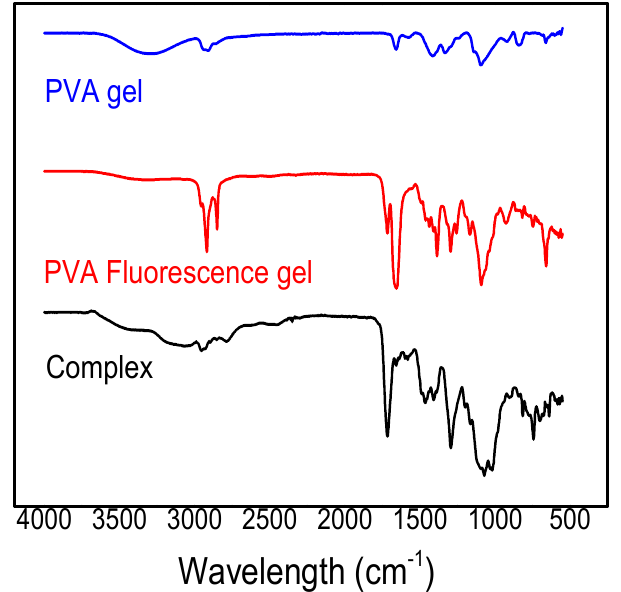
Figure 2. Fourier-transform infrared spectra (FTIR) of modified Eu 3 + / Tb 3 + complex. Table 1. Energy-dispersive X-ray-spectroscopy results for Tb / Eu fluorescent gel. Element wt.% at.